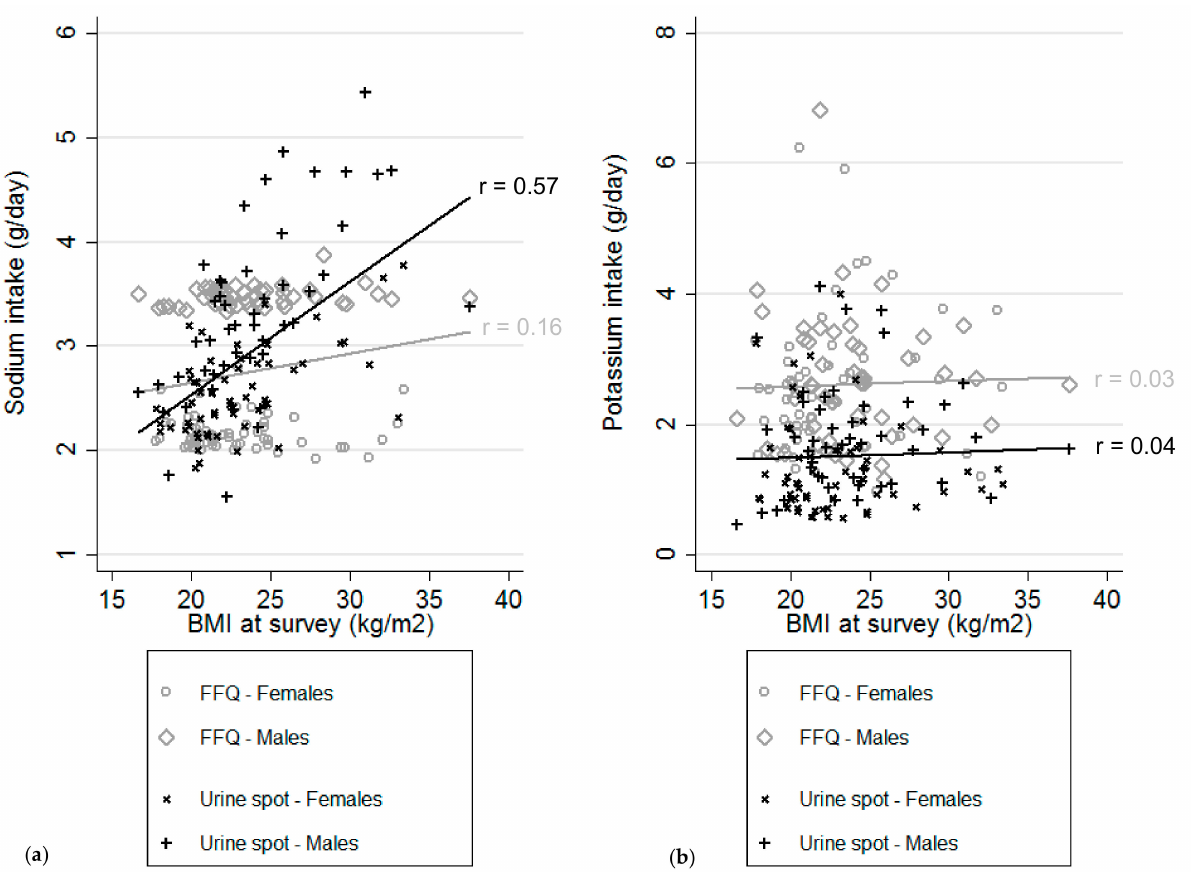
Figure 2. Cardiovascular risk profile B—correlation between BMI and sodium 1 ( a ) and potassium ( b ) measurements by food frequency questionnaire (FFQ) and morning fasting spot urine samples. BMI—body mass index; FFQ—food frequency questionnaire. 1 Sodium (Na) intake based on FFQ data was calculated with the equation: (8.20 + 0.38 × FFQ in males) / 2.54 and (4.55 + 0.67 × FFQ in females) / 2.54, with 1 g Na = 2.54 g salt (NaCl) see [25]. Intake based on FFQ data only gives a mean daily intake of 1.9 g ±